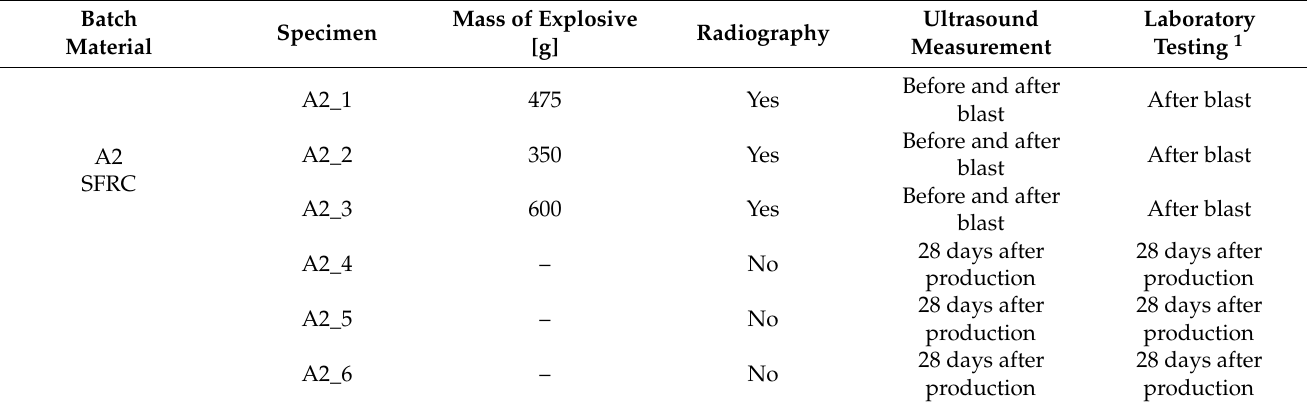
Table 4. Overview of testing for a batch of specimens A2.